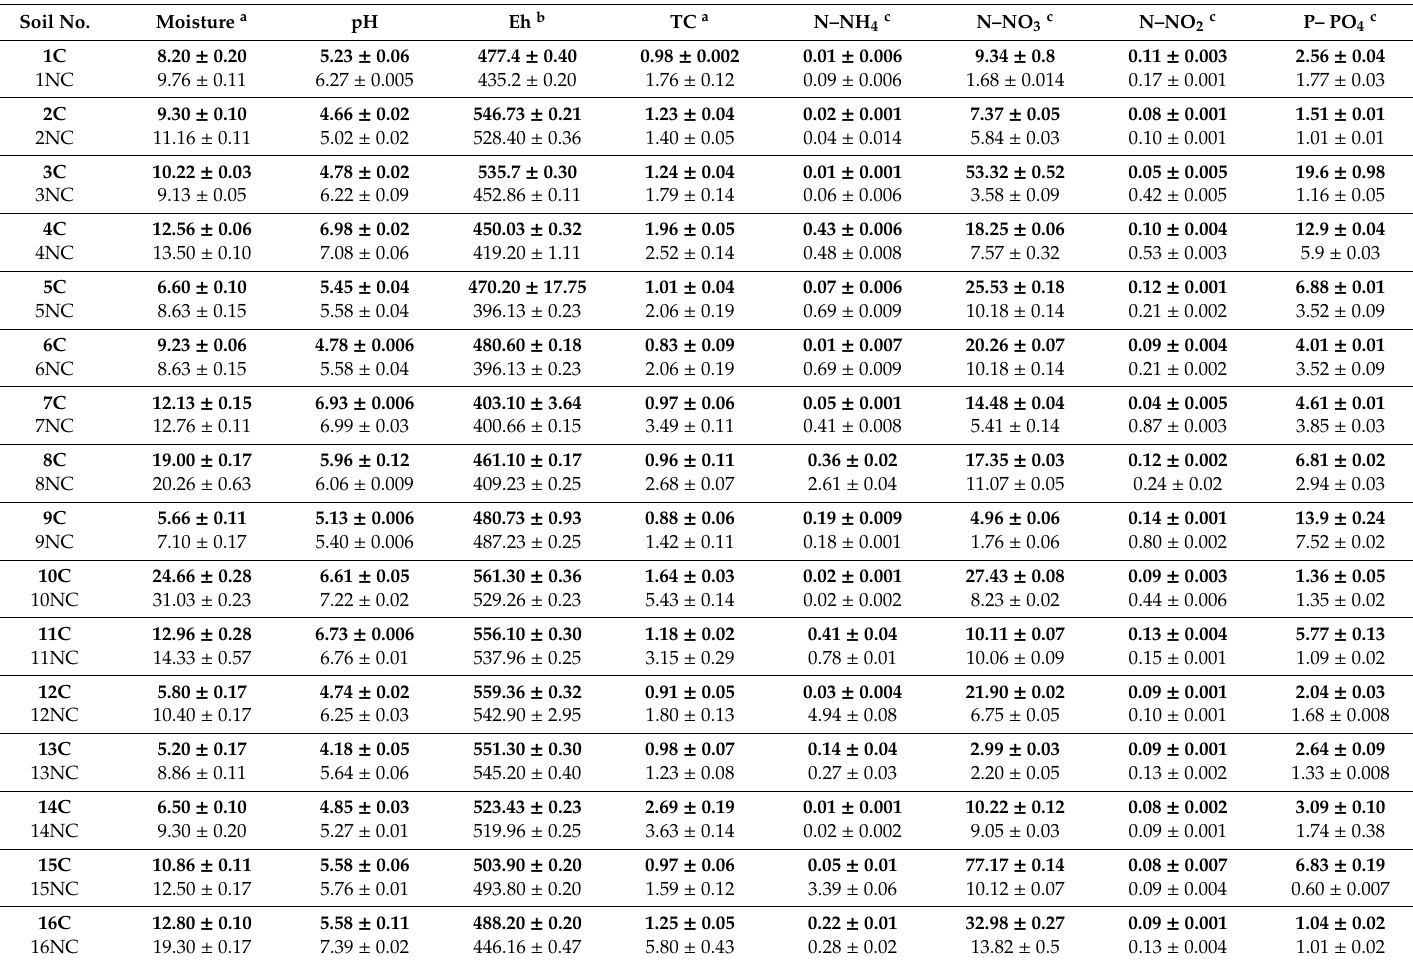
Table 2. Selected chemical features of the studied soils ± SD (C—cultivated, agricultural, bolded; NC-control, non-cultivated soils). Soil